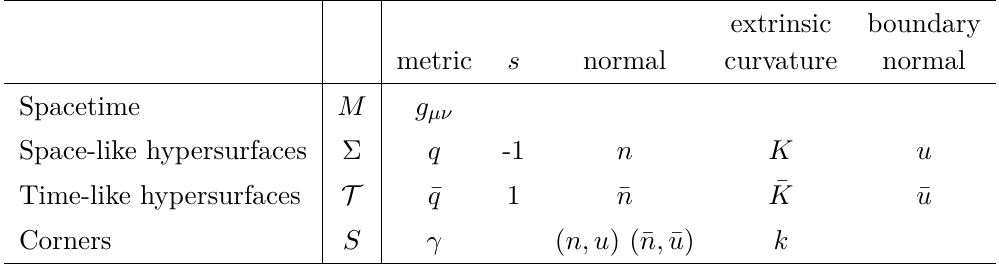
Table 1 . Notations for the different